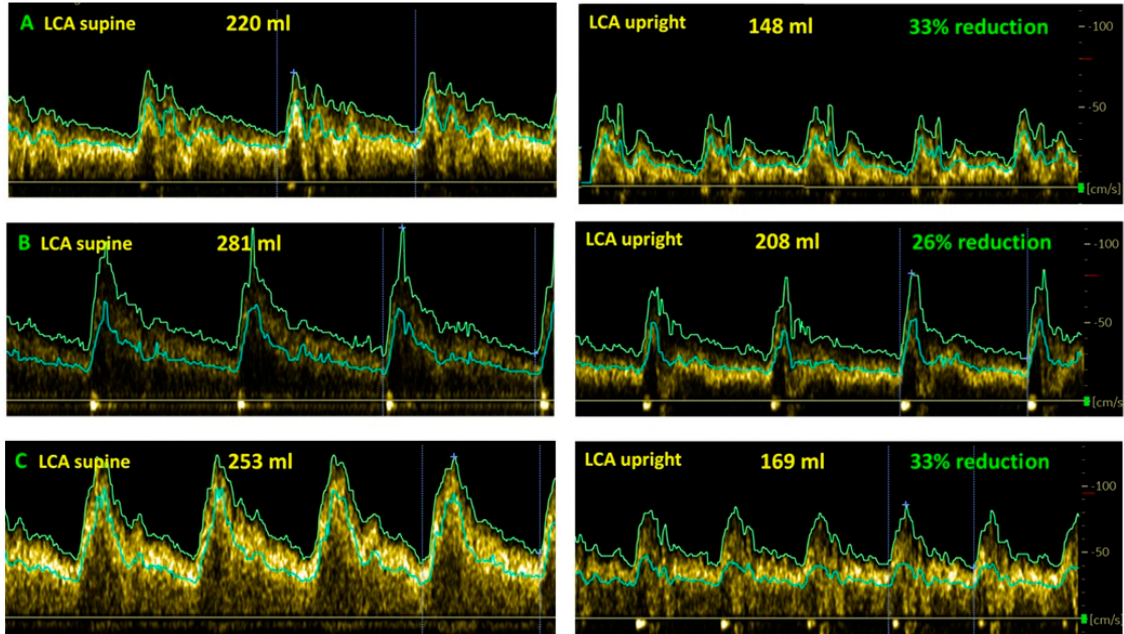
Figure 4. Examples of cerebral blood flow decrease while upright compared to supine in ME/CFS patients with a trigger of EBV. ( A ): female, 38 years; ( B ): female, 21 years old; ( C ): female, 23 years LCA: left carotid